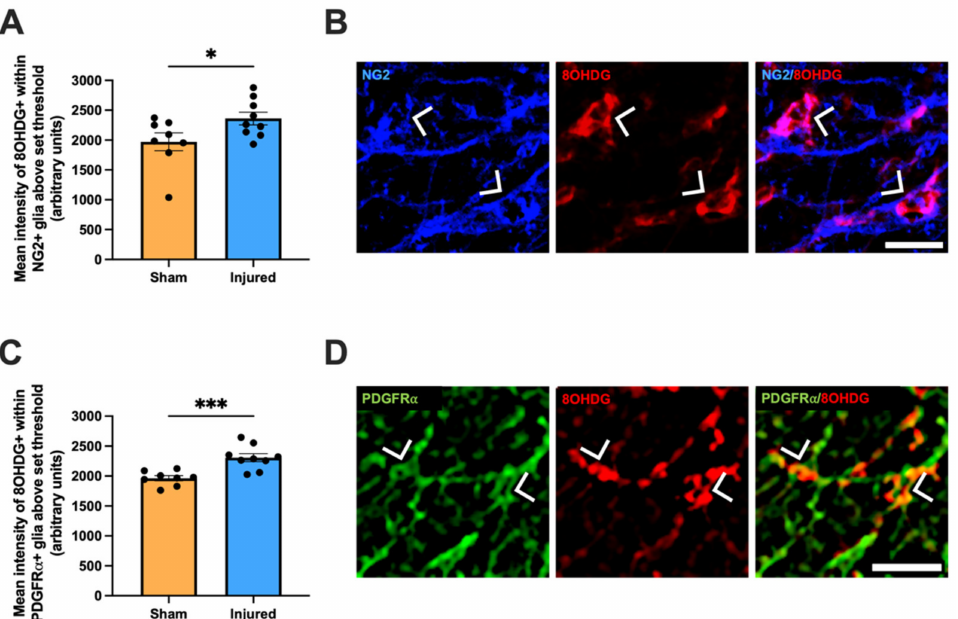
Figure 4. Effect of injury on oxidative DNA damage within NG2+ glia and PDGFR α + glia. The mean immunointensity of 8OHDG was specifically quantified in NG2+ glial cells ( A ) and PDGFR α + glia cells ( C ) in the ventral nerve. Graphs display individual data points overlaid on a bar displaying the mean ± SEM. n = 8–10 rats per group. Statistical analysis by t -tests. Representative images of NG2+ glia ( B ) and PDGFR α + glia ( C ) with 8OHDG+ DNA damage are shown, indicated with arrow heads, scale bars = 20 µ m. No outliers were removed for any outcome measure. Significant differences are indicated by * p ≤ 0.05, *** p ≤